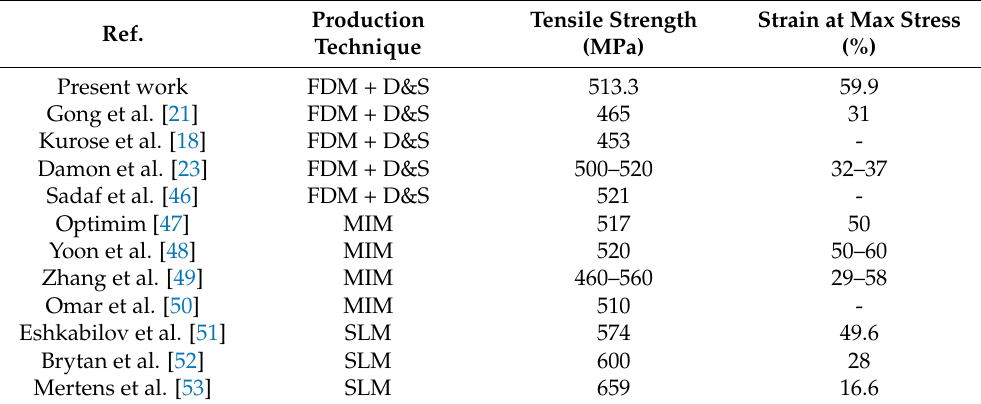
Table 12. Comparison of the tensile properties achieved in the present work with those reported in previous works and other commercial production techniques.